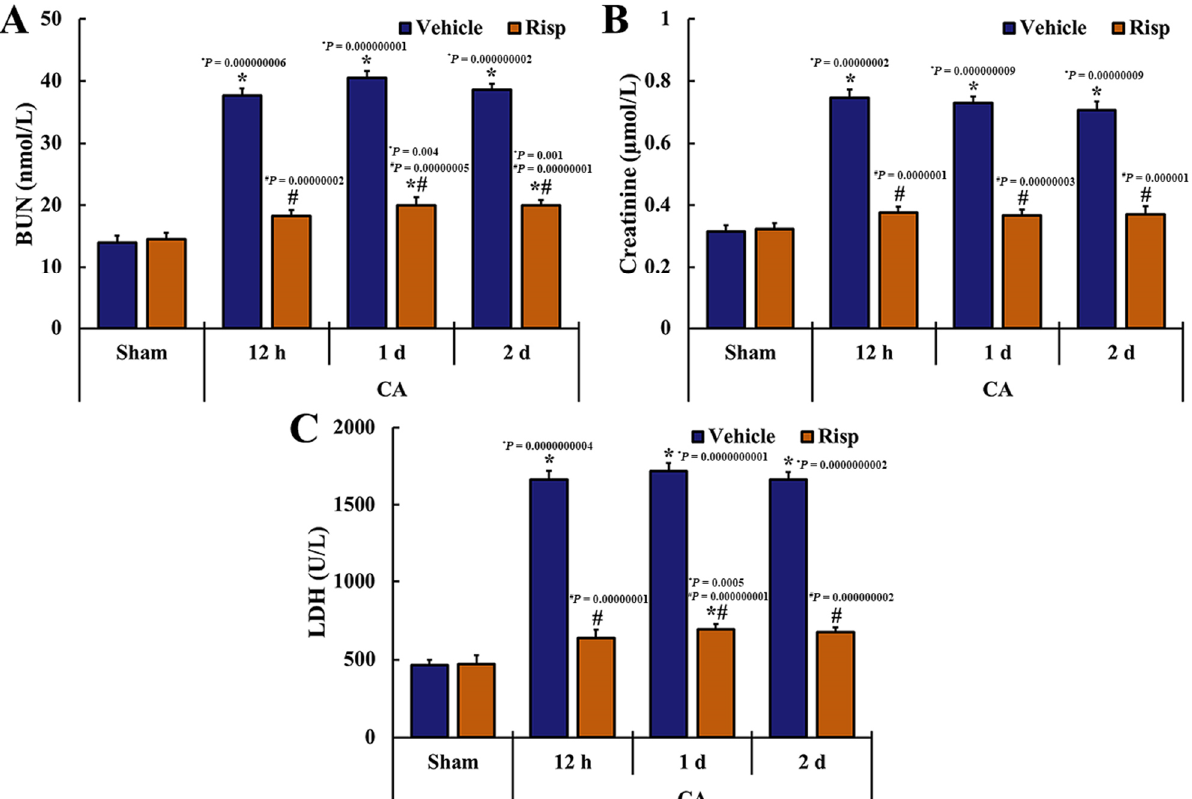
Figure 3. Changes in levels of BUN ( A ), creatinine ( B ), and LDH ( C ). The levels were determined at 12 h, one day, and two days after CA/ROSC. The levels of BUN, creatinine, and LDH in the CA-Risp group were significantly ( p < 0.05) low when compared with the CA-vehicle group. The bars indicate the means ± SEM ( n = 7, respectively; * p < 0.05 vs. Sham-vehicle group; # p < 0.05 vs. CA-vehicle group).